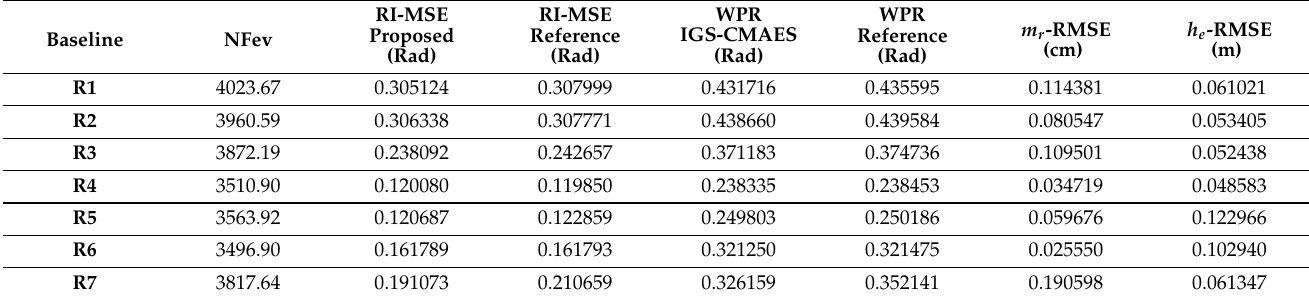
Table 4. Quantitative assessment of IGS-CMAES’s outputs with reference